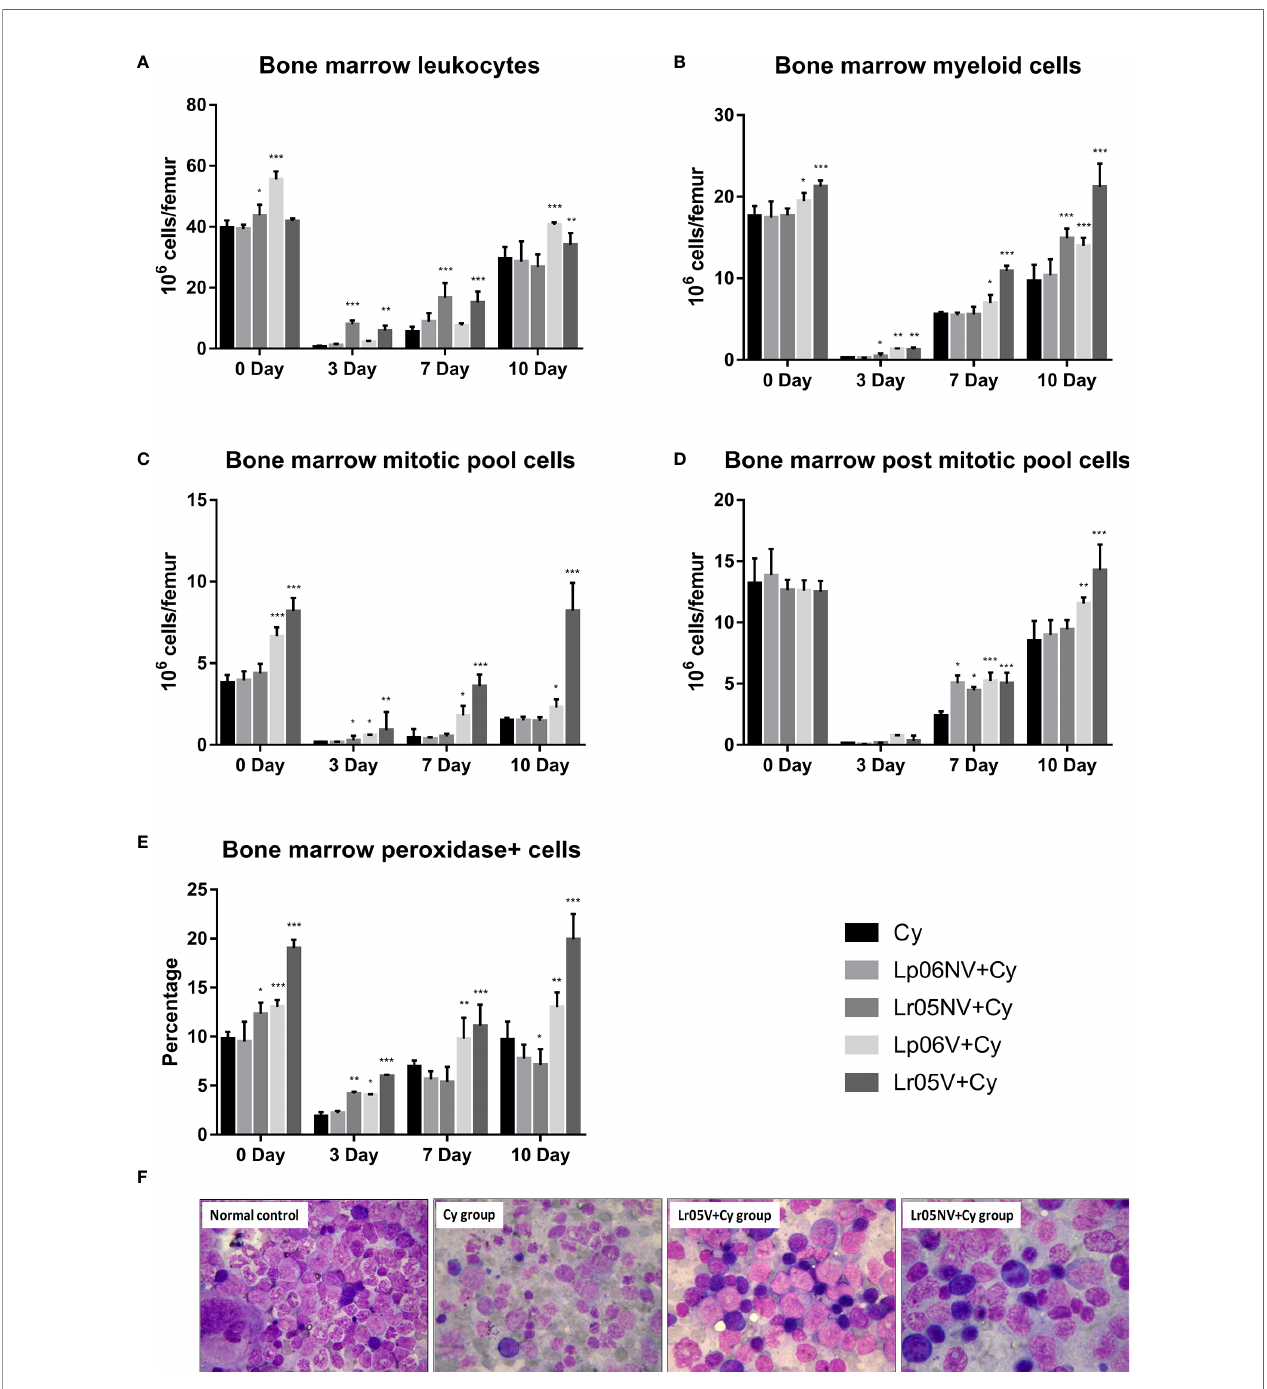
FIGURE 3 | Bone marrow leukocytes. 6-week-old Swiss mice were fed with 10 8 cells/mouse/day of viable or non-viable Lactobacillus rhamnosus CRL1505 (Lr05V+ Cy or Lr05NV+Cy groups) or L. plantarum CRL1506 (Lp06V+Cy or Lp06NV+Cy groups) for 5 consecutive days before injection of Cy. The treated groups and the untreated control mice (Cy group) received one dose of 150 mg/kg Cy intraperitoneally. Bone marrow leukocytes (A) , myeloid cells (B) , mitotic pool cells (C) , post- mitotic pool cells (D) and peroxidase + cells (E) , counts were performed on day 0, before Cy administration, and days 3, 7 and 10 post-Cy administration. The results come from two independent experiments. Six animals per group each time were used in the experiments. Results are expressed as mean ± SD . ***,**,* Signi fi cant differences from the Cy group should be as follows (p<0.0001, p<0.001 or p< 0.05 respectively). Photomicrographs of May Grünwald Giemsa-stained smears of bone marrow on day 3 post-Cy (Magni fi cation X400) of normal control, and Cy, Lr05V+Cy and Lr05V+Cy groups (F)